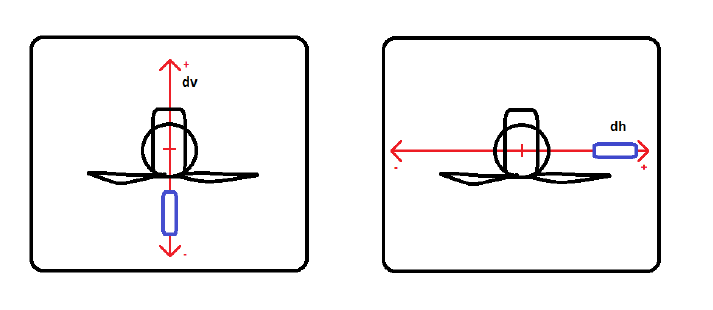
Figure 3. Displacement of the TMD along the fore–aft ( left ) and side–side ( right ) axis. The results of moving a single TMD from dv = –18 m to dv = +18 m, every 3 m, in the fore–aft or downwind direction, which is, in the direction in which the turbine is oriented (dv axis), are shown in Figure 4. In all of the images, the orange line represents the response of the wind system without TMD and, in blue, the wind turbine with the TMD in different positions.